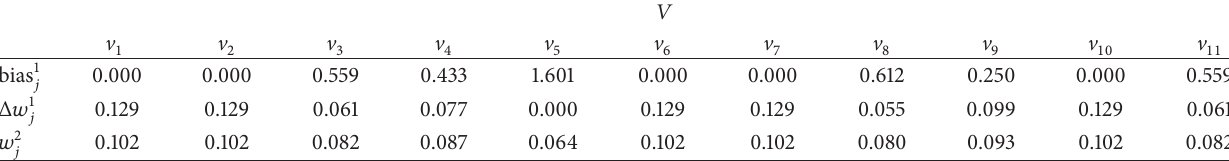
Table 1: Weights correction results of the first stage voting.